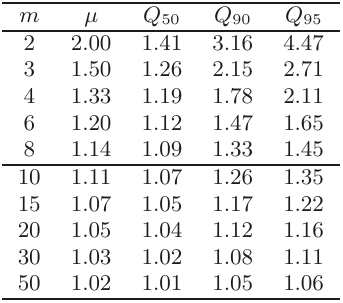
Table 1. Mean and specified quartiles associated with the Pareto distribution p ( F | F 0 ) in (2) for F 0 = 1 and different values of m